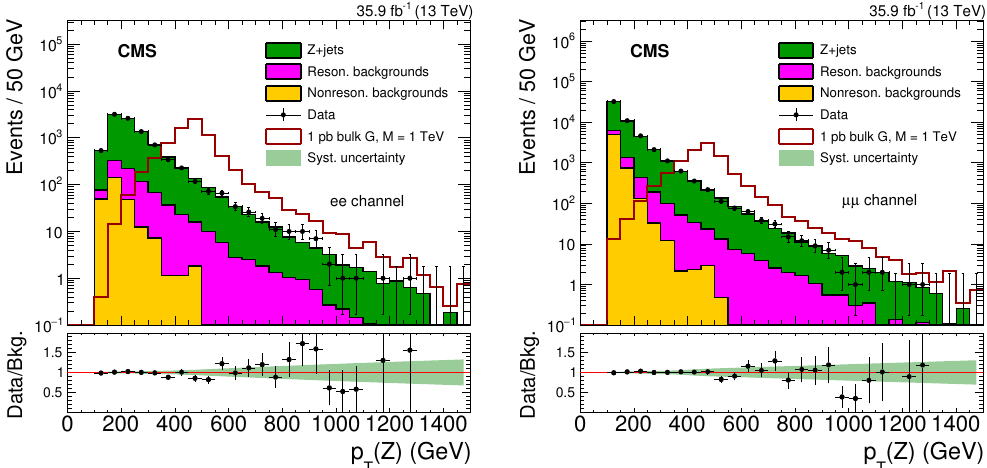
Figure 2 . The p Z distributions for electron (left) and muon (right) channels comparing the data T and background model based on control samples in data. The lower panels give the ratio of data to the prediction for the background. The shaded band shows the systematic uncertainties in background, while the statistical uncertainty in the data is shown by the error bars. The expected distribution for a zero width bulk graviton resonance with a mass of 1 TeV is also shown for a value of 1 pb for the product of cross section and branching fraction (cid:27) (pp ! X ! ZZ) B (ZZ ! 2 ‘ 2 (cid:23)